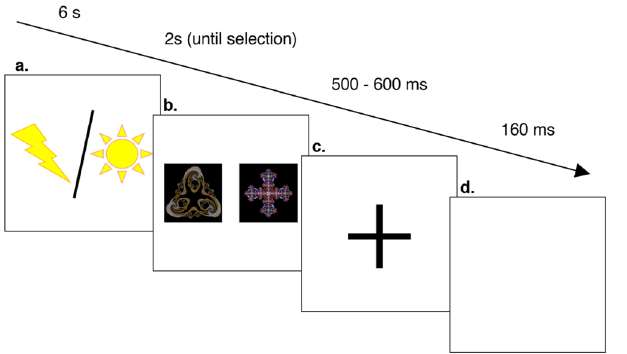
Figure 1. ( a ) Icon indicates if trial is high or low stakes, with noise administered on 20% trials at a random point between 2 and 5 s. ( b ) Participant selects from a pair of fractals. ( c ) Cross indicates shock is coming. ( d ) Shock is